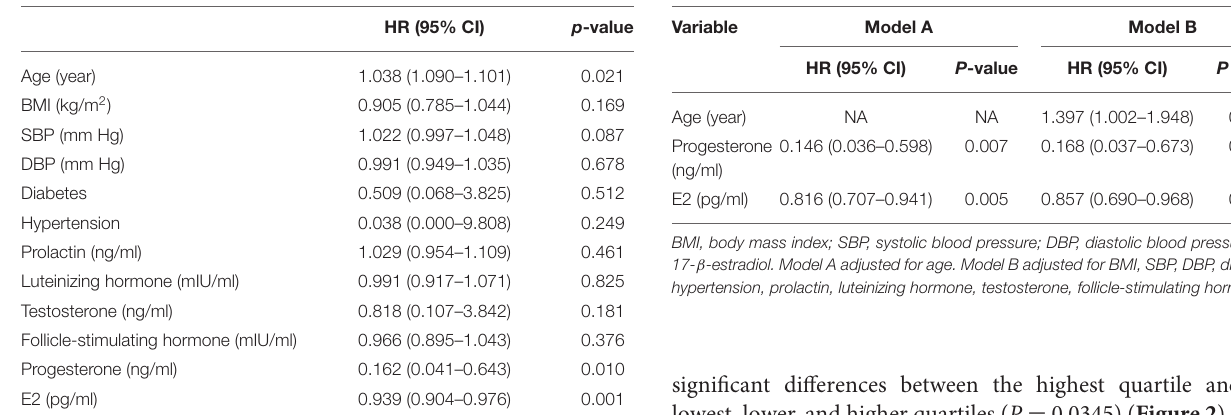
TABLE 2 | Factors associated with 30-day mortality using univariate Cox proportional Hazard analysis.